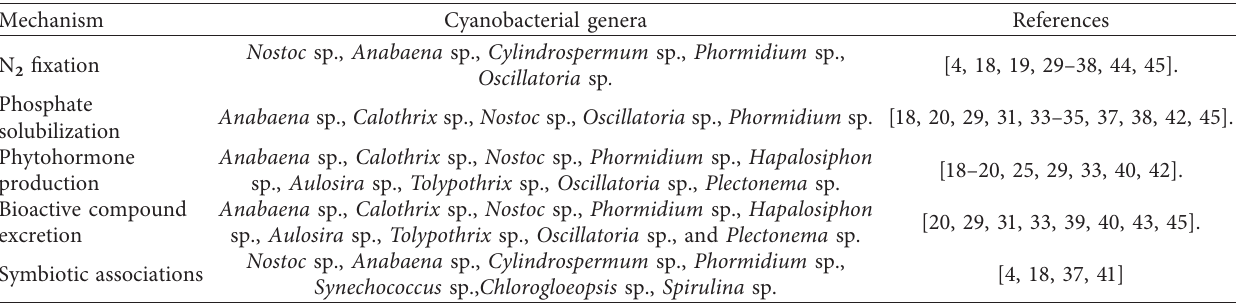
Table 3: Cyanobacterial genera classified according to their PGPR action mechanisms o PGP characteristics